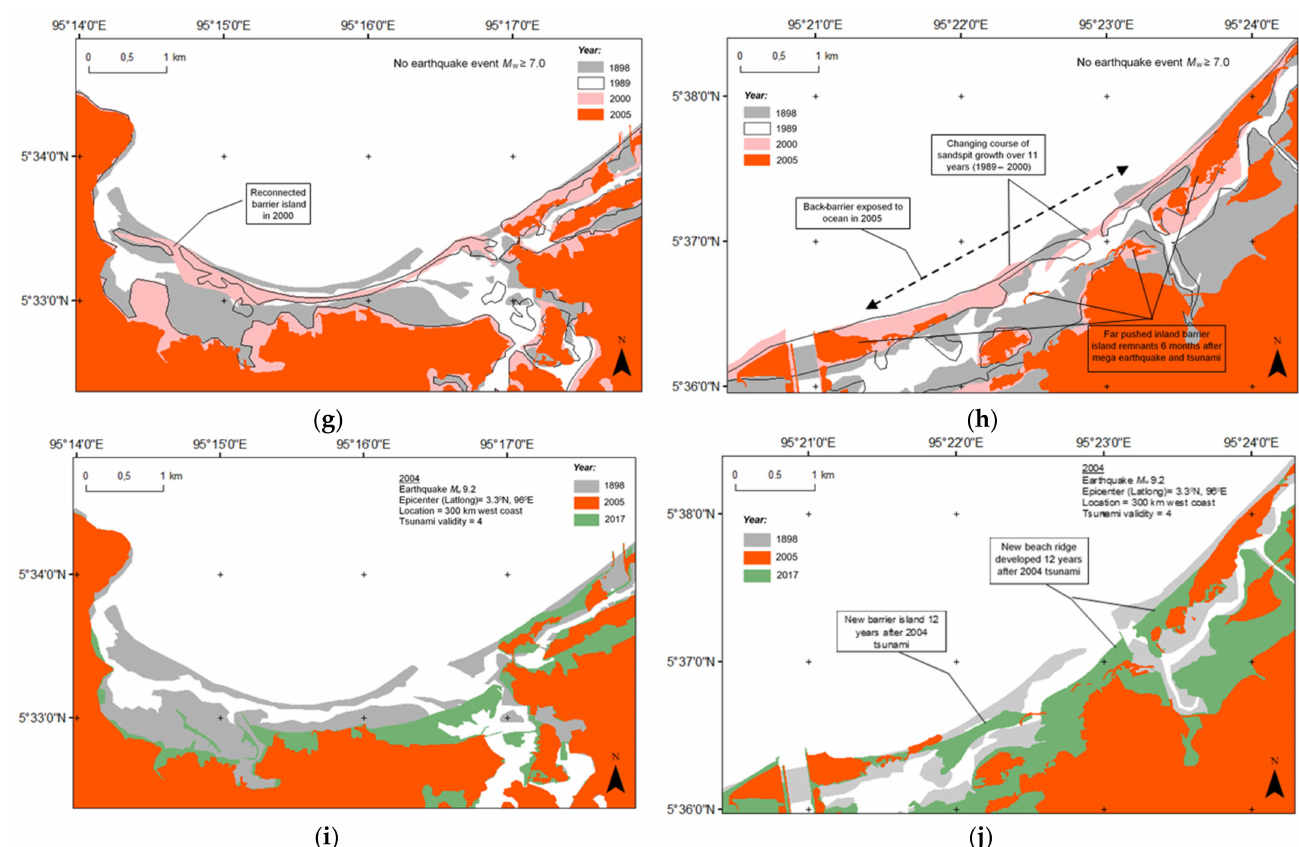
Figure 7. Observation of barrier island morphological changes from the consecutive pairs of shoreline delineation of Lambadeuk and Kuala Gigieng coastal section, at the northern tip of Sumatra Island: ( a , b ) Changes at Lambadeuk and